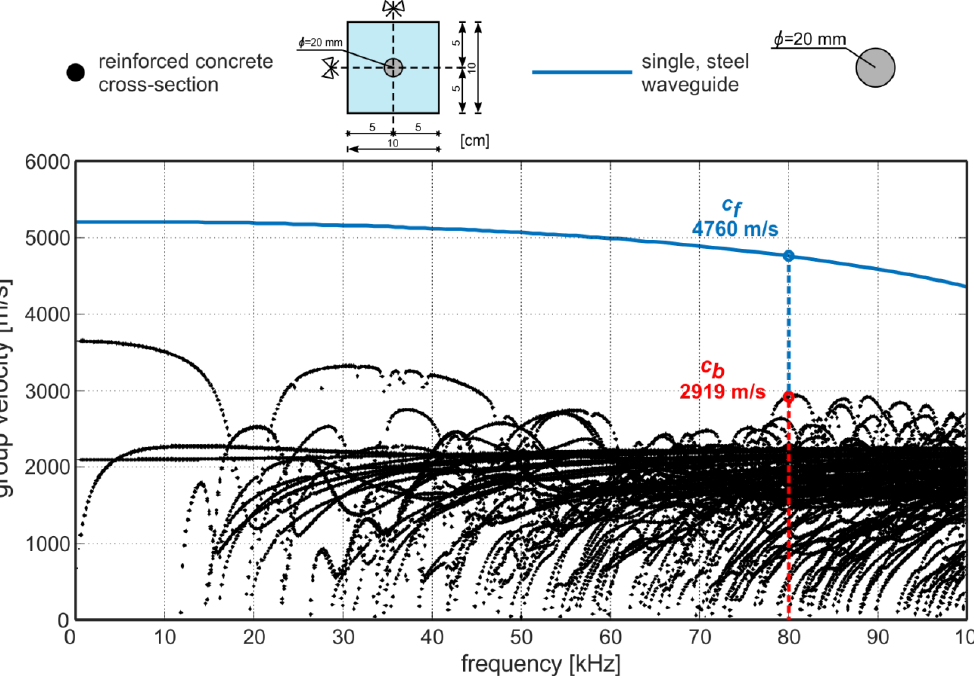
Figure 1. Dispersion curves for (•) reinforced concrete (RC) cross-section (concrete: E = 27 GPa, v = 0.18, ρ = 2290.4 kg/m 3 , steel: E = 212 GPa, v = 0.3, ρ = 7815 kg/m 3 ), and for (-) uncovered, steel rod ( E = 212 GPa, v = 0.3, ρ = 7815 kg/m 3 ).